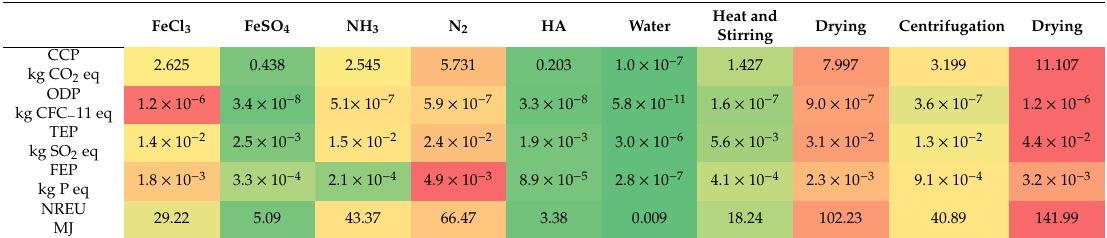
Table 1. Impact at the midpoint level for the synthesis process of 1 kg of the catalyst (Fe 3 O 4 / HA). FeCl 3 FeSO 4 HA Water Heat and Stirring Drying